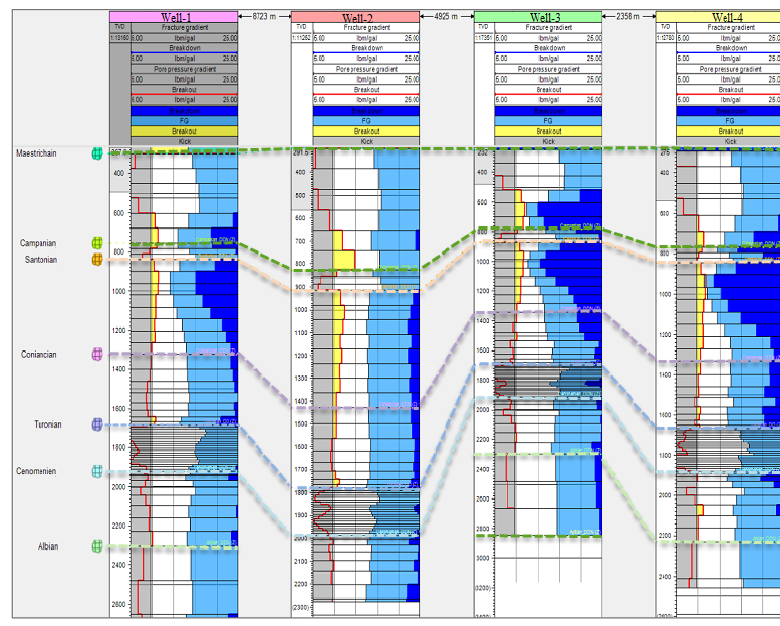
Figure 16. Mud weight windows for the four wells compared to that of well 5.